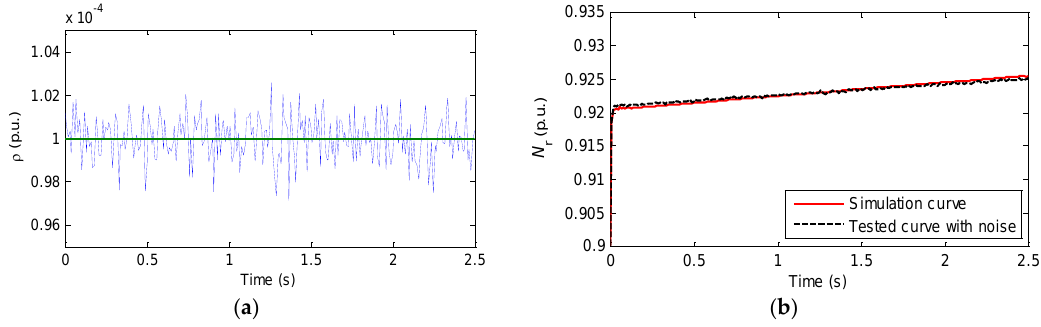
Figure 15. Comparison results tested data in case of tested data with random noise. ( a ) Input signal with random noise; and ( b ) simulation comparison of N r with random noise.